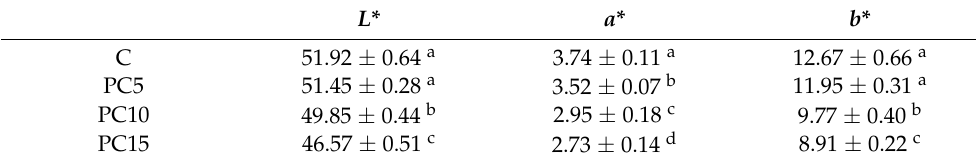
Table 5. Color parameters of oatmeal cookies with poppy seed expeller added ( n =